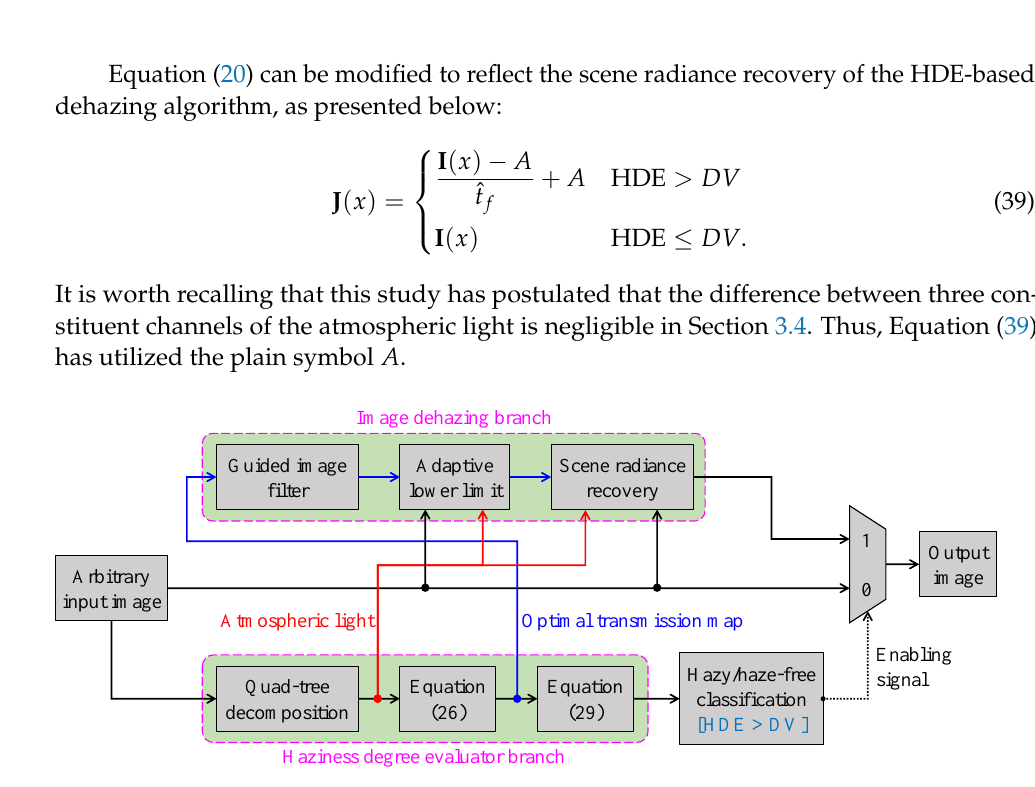
Figure 11. Block diagram of the HDE-based dehazing